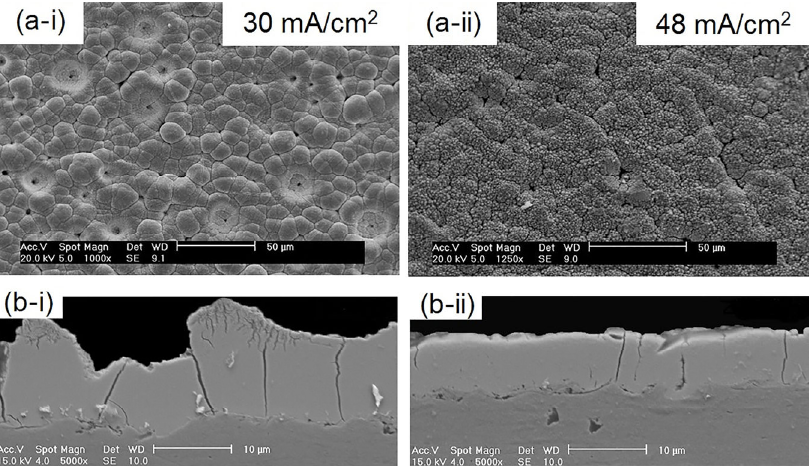
Fig. 5 (a) Surface morphology, and (b) cross-section images of trivalent chromate passivated Zn–Ni coatings electroplated at current density of (i) 30 mA/cm 2 and (ii) 48 mA/cm 2 . Reproduced with permission from Ref. [64], © Elsevier, 2013.